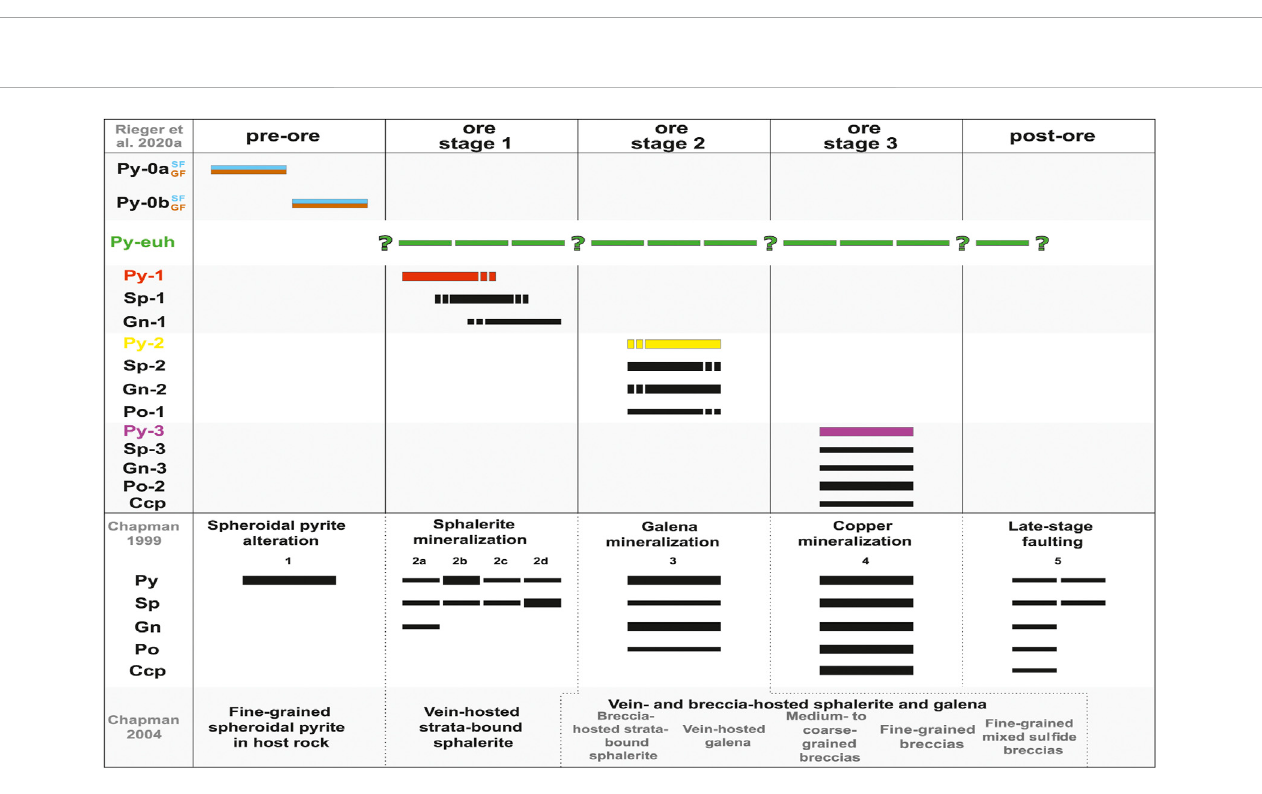
Paragenetically constrained sulfur isotope data indicate that 1) Py-0 formed from reduced sulfur produced via open system microbial sulfate reduction, 2) reduced sulfur for Py-1, Py-3, and Py-euh was derived via thermochemical sulfate reduction, whereas 3) Py-2 formed via the replacement, recycling, and recrystallization of pre-existing Py-0 and Py-1 (Rieger et al., 2020a).